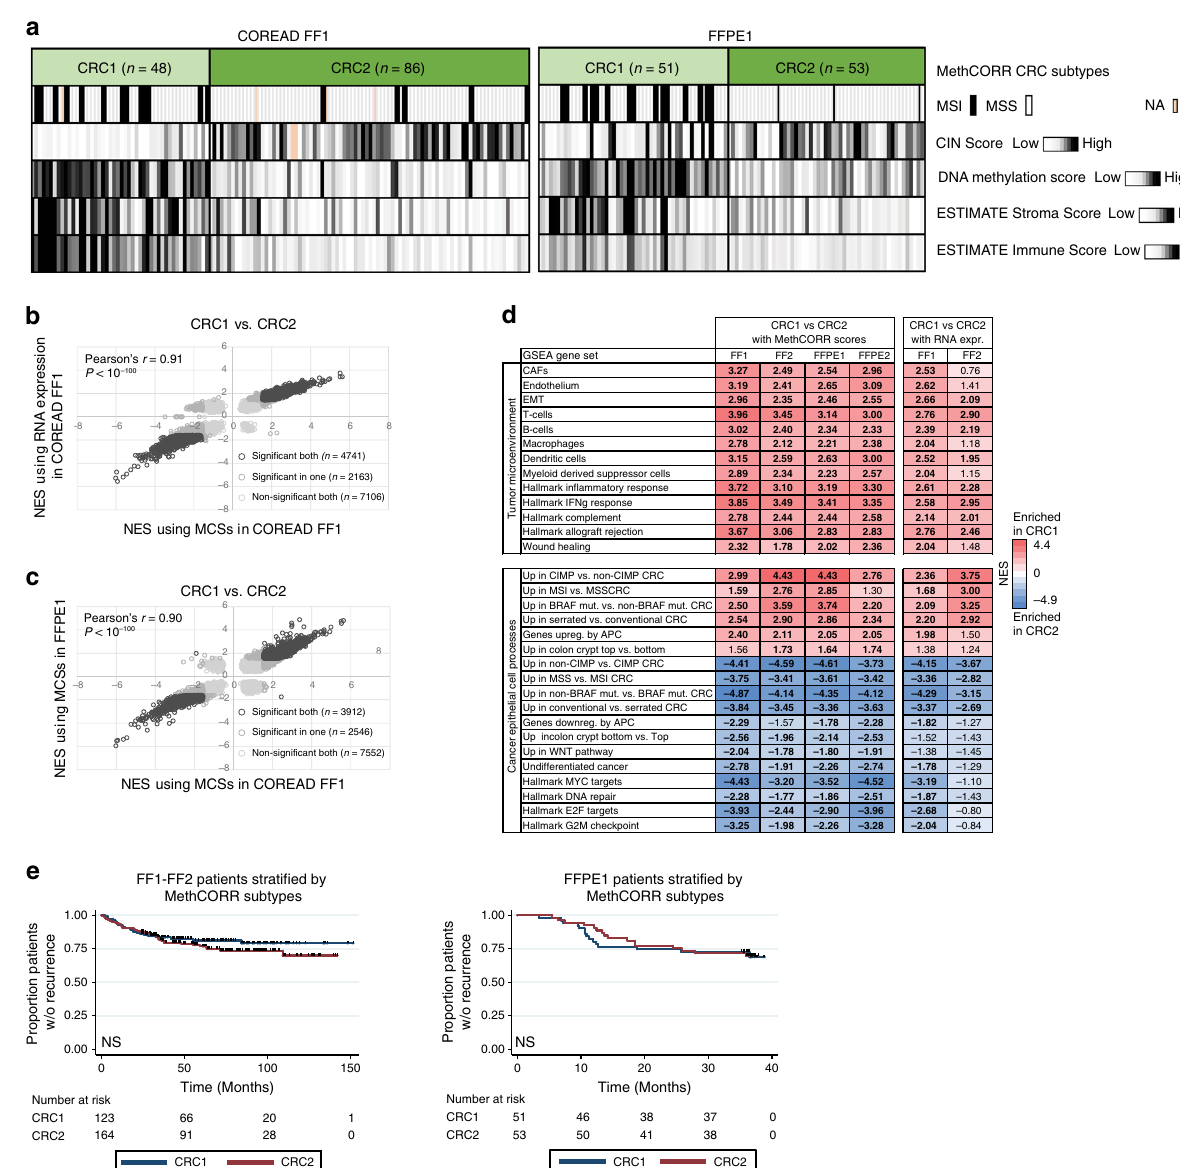
Fig. 2 MethCORR based NMF clustering identi fi es the same two CRC subtypes in fresh-frozen and FFPE cohorts. a Main molecular features of the CRC1 and CRC2 MethCORR subtypes in the COREAD FF1 and the FFPE1 cohort (Supplementary Table 1). MSI and MSS status is indicated in black and white. CIN scores were derived for COREAD and FFPE1 samples using GISTIC and EPIC DNA methylation data, respectively, and sample DNA methylation scores were calculated as the 40th percentile of DNA methylation β -values for all CpGs. Stroma- and Immune Scores were generated from MCSs using the ESTIMATE software 69 . b – c Scatterplots showing the correlation between normalized enrichment scores (NESs) for ~17 K gene sets of The Molecular Signatures Database (MSigDB) v6.1 from a pre-ranked GSEA of CRC1 vs. CRC2 subtypes in the COREAD FF1 cohort using either MCSs ( X -axis) or RNA expression ( Y -axis) as input ( b ) and a pre-ranked GSEA of CRC1 vs. CRC2 subtypes in either the COREAD FF1 cohort ( X -axis) or FFPE1 cohort ( Y -axis) using MCSs as input ( c ). Pearson ’ s r and P value (Wilcoxon rank sum test) is indicated. d Table showing selected gene sets differentially enriched between CRC1 and CRC2 subtypes as evaluated by pre-ranked GSEA performed using MCSs or RNA expression in the fresh-frozen COREAD FF1 and SYSCOL FF2 cohorts and MCSs for the FFPE cohorts (Supplementary Table 1). Gene sets with positive NES are enriched in CRC1 (red colors), whereas negative NES indicate enrichment in CRC2 (blue colors). Gene sets enriched/depleted at a high signi fi cance level are highlighted in bold (FDR < 0.05). See methods section and Supplementary Table 3 for origin of gene sets. e Kaplan – Meier plots showing the relapse-free survival of CRC patients strati fi ed according to subtype. Left panel: patients with fresh-frozen tumors and good clinical follow-up (the COREAD FF1 and SYSCOL FF2 cohorts; Supplementary Table 1) were combined to increase the number of relapse events. Right panel: patients with FFPE tumors and good clinical follow-up (The FFPE1 cohort; Supplementary Table 1). Signi fi cance was evaluated by the log-rank